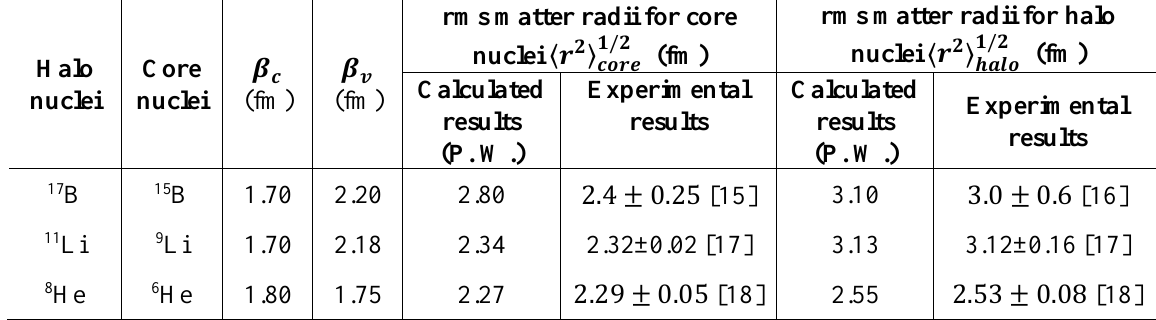
Table 1: The Parameters for β and β utilized in the TFSM of the present study together with c v the calculated and experimental rms radii of exotic nuclei ( 17 B, 11 Li, 8